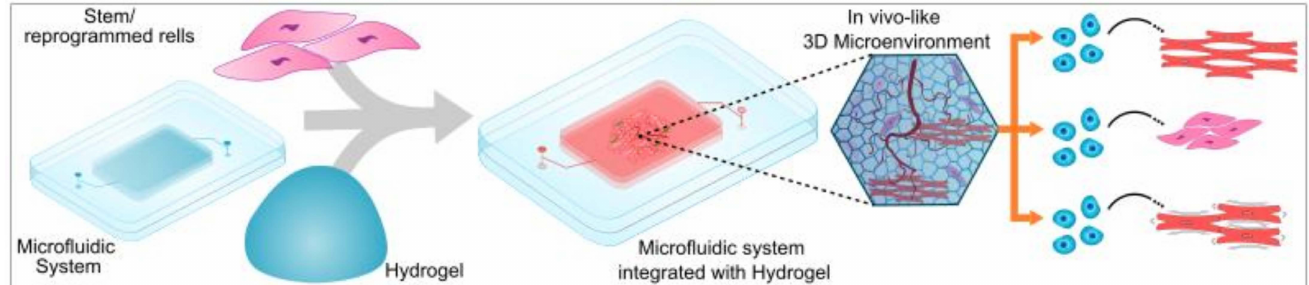
Figure 6. Microfluidic system integrated with hydrogels and cells to provide in-vivo-like 3D microen- vironment with biochemical and biophysical cues that result in enhanced differentiation of stem cells or reprogrammed cells, generate functionally mature tissue specific cells and enable a structurally organized